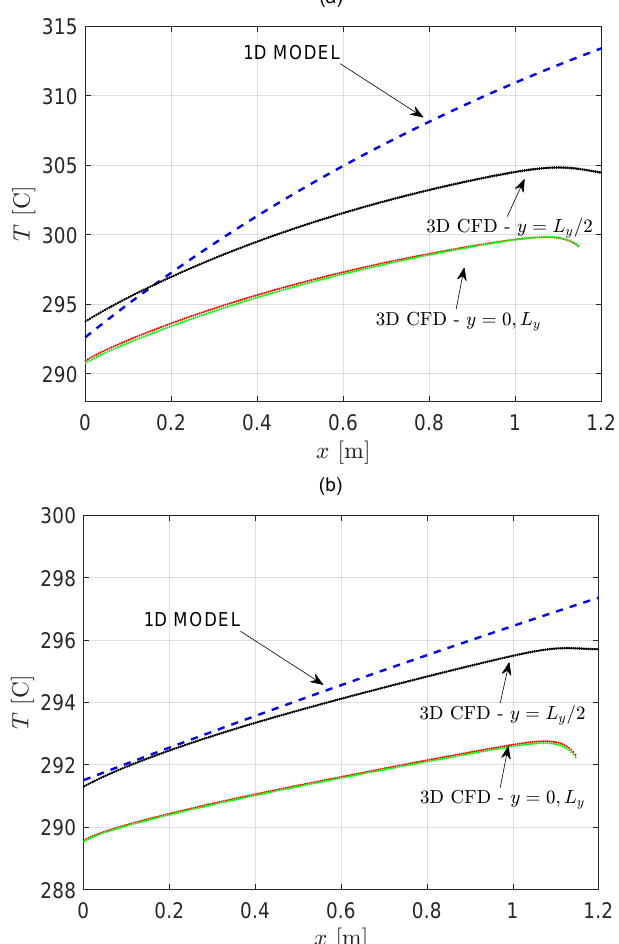
Figure 10. Spatial distribution of the cell temperature for ( a ) ˙ v = 200 and ( b ) 1000 L/h. Cell temperatures obtained with the three-dimensional model at different y were compared with the cell temperature profile obtained with the one-dimensional model (dashed line). Simulations were performed using an average day of July in Catania (Southern Italy), with orientation SOUTH and tilt 33 ◦